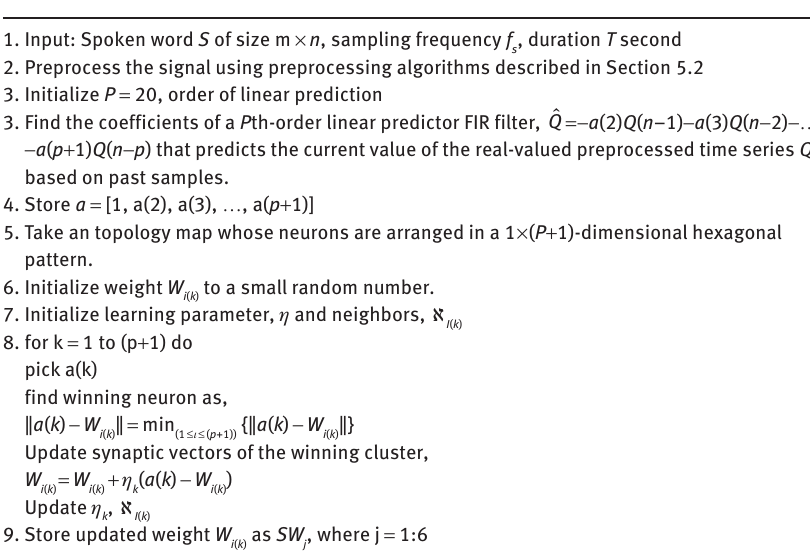
Table 1. SOM Weight Vector Extraction